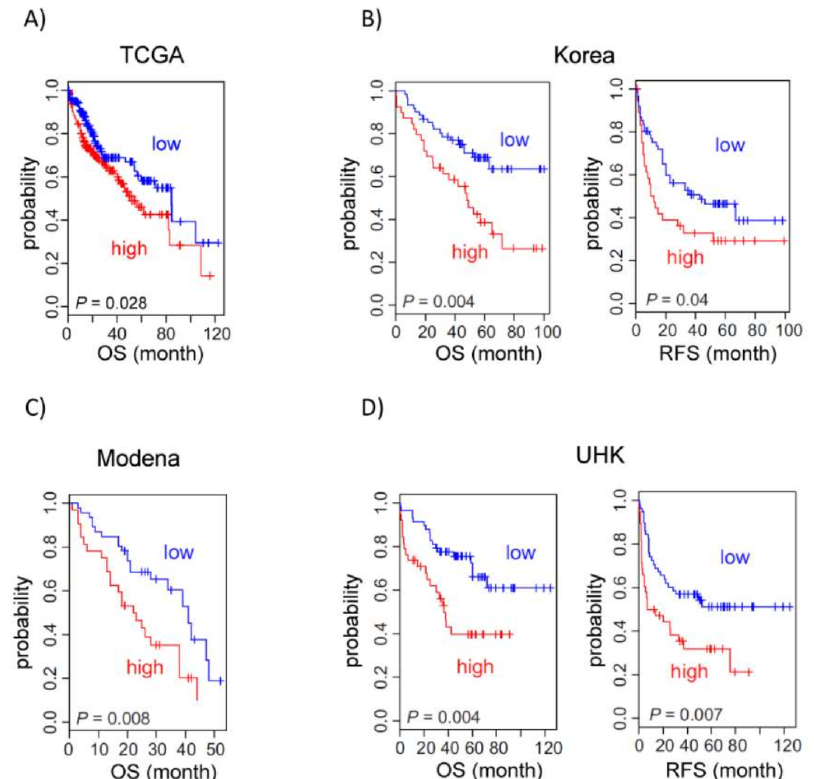
Figure 2. Kaplan–Meier survival curves show that midnolin expression in hepatocellular carcinoma (HCC) correlates with poor patient prognosis. When patients were dichotomized by midnolin expression level in HCC, high expression of midnolin was significantly associated with poor overall survival (OS) and poor relapse-free survival (RFS). ( A ) TCGA data ( n = 365, median cutoff); ( B ) Korea cohort ( n = 100, 40th percentile cutoff) [12]; ( C ) Modena cohort ( n = 76, 40th percentile cutoff) [13]; and ( D ) University of Hong Kong (UHK) cohort ( n = 96, 40th percentile cutoff)